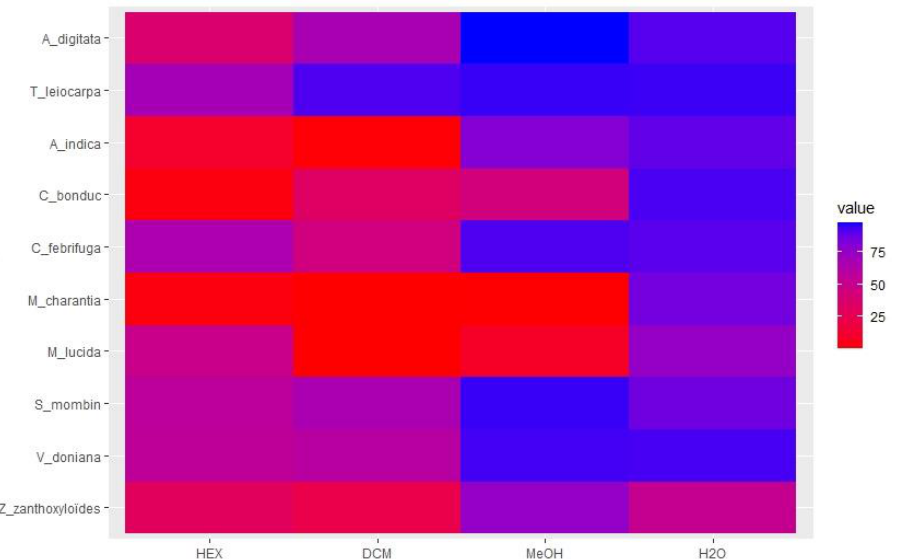
Figure 7. Heatmap of WI38 cells viability (compared to negative control considered as 100%) treated with extracts (100 µ g/mL). HEX: hexane; DCM: dichloromethane; MeOH: methanol; and H 2 0: water. DMSO (0.5%) was used as a negative control.